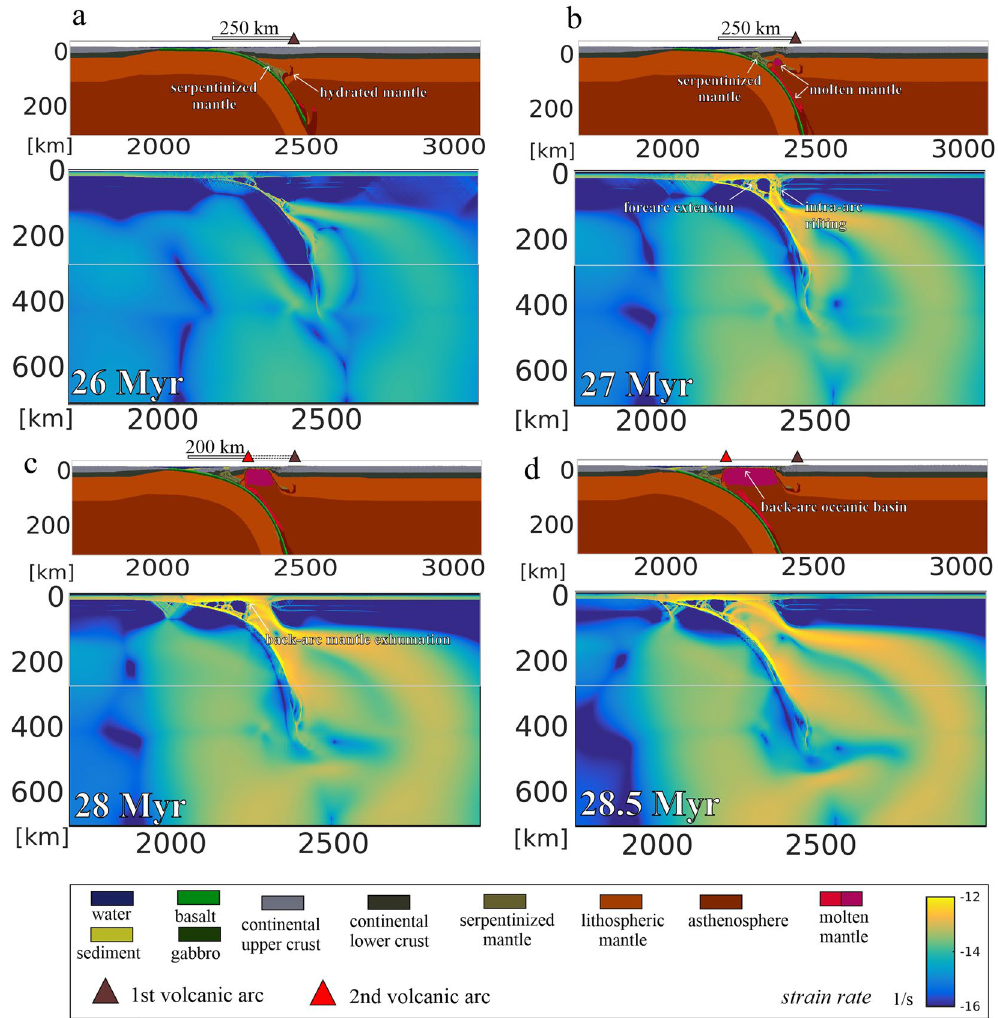
Figure 3. Thermo-mechanical model simulating the transition from forearc to backarc basin shown by strain rate results overlain by rock composition evolution. ( a ) Formation of a volcanic arc and forearc basin subsidence. ( b ) Arc rifting driven by melt induced weakening. ( c ) Slab retreat and backarc rifting. ( d ) Continued slab retreat and backarc basin formation in the previous forearc